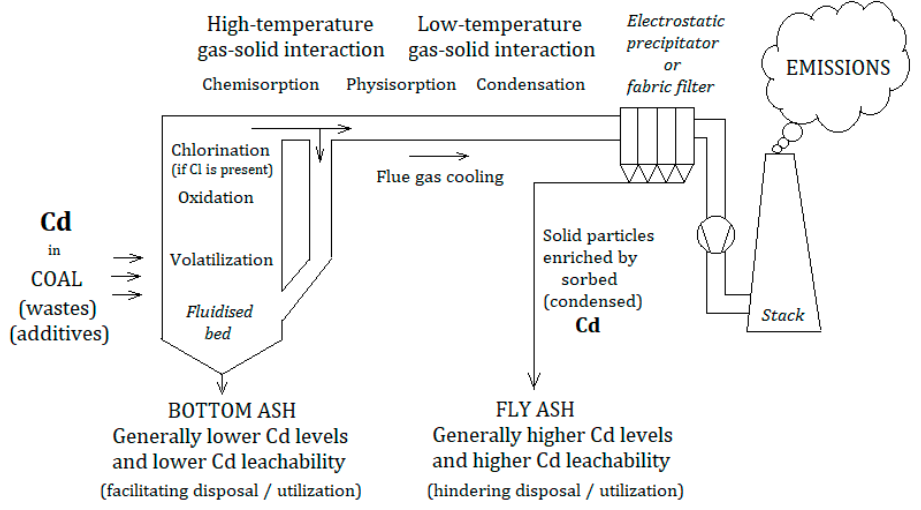
Figure 1. Partitioning of Cd during coal combustion at fluidised ‐ bed power station.